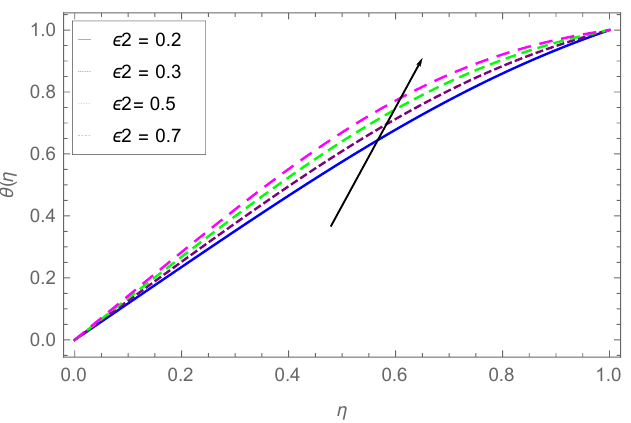
Figure 10. Plot depicting θ ( η ) dependence on (cid:101) 2 . The dependence of θ ( η ) on η for varying (cid:101) 3 is displayed in Figure 11. We observed the same behavior as in the case of Figure 10. This increase in the temperature with increasing values of (cid:101) 3 is due to increasing nanofluid-specific heat.